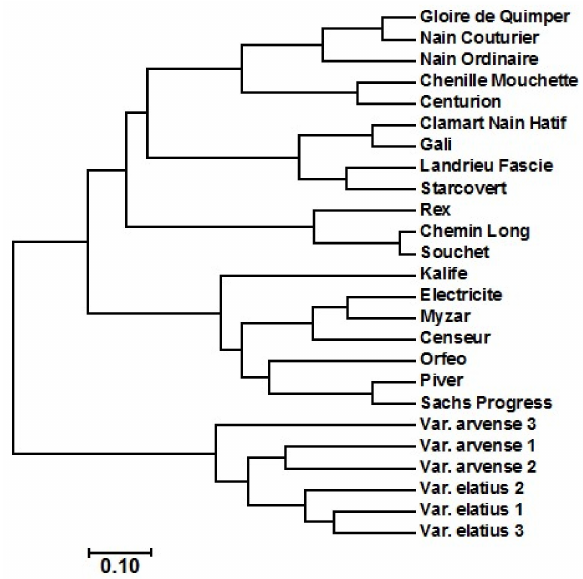
Figure 3. Cluster analysis of the 25 accessions of Pisum sativum L. using AFLP